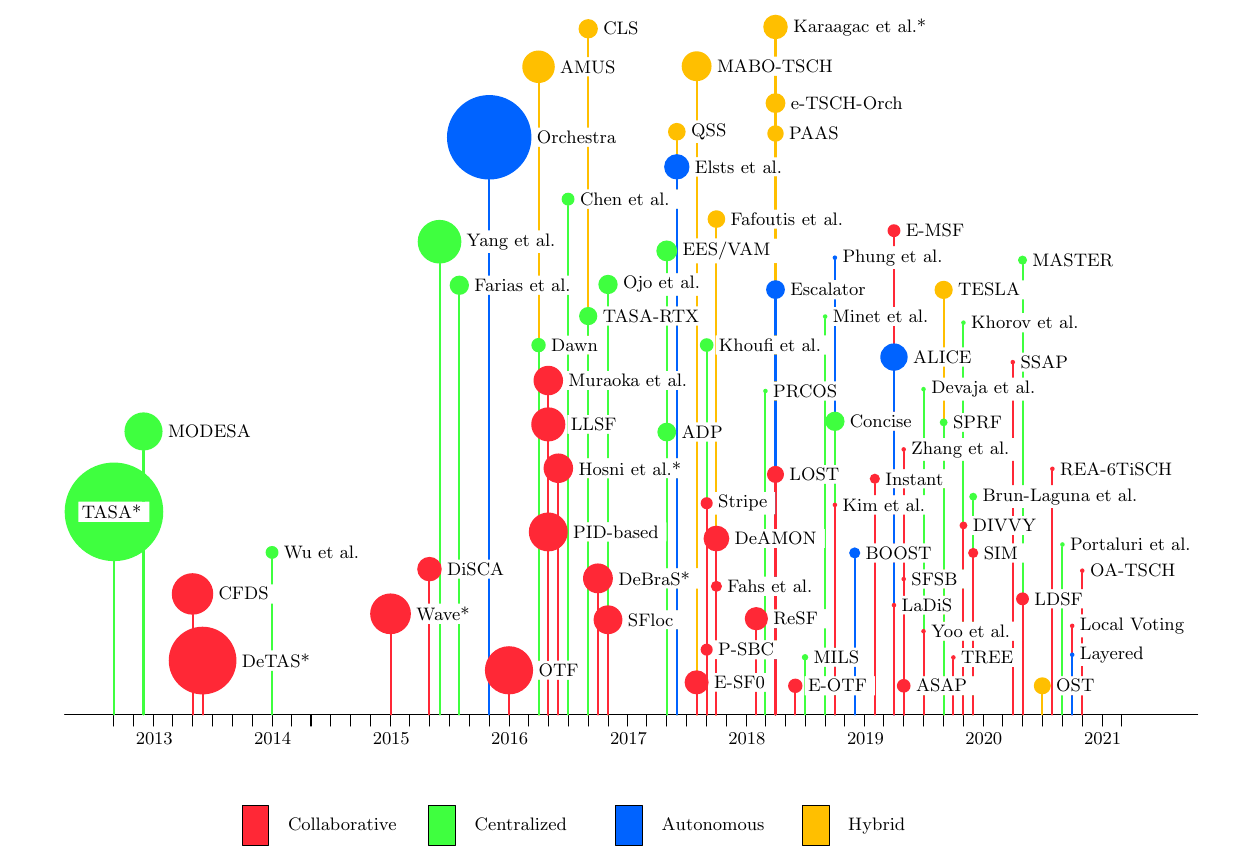
Figure 6. Timeline of schedulers. Size of bubble is relative to number of citations according to Google Scholar. * indicate multiple publications for same scheduler—earliest publication date is shown .